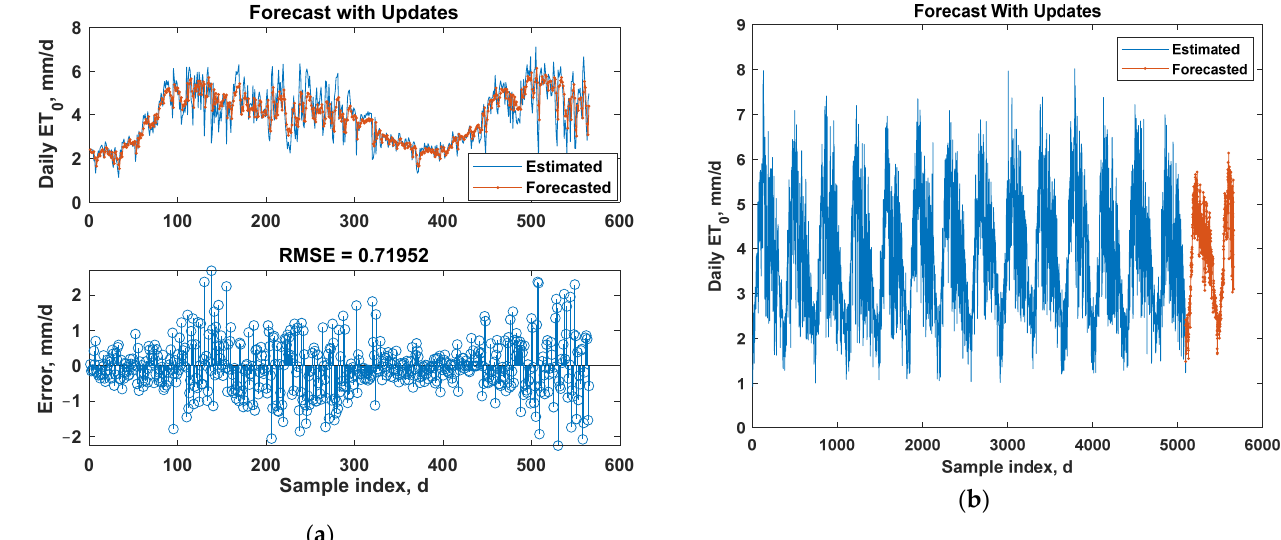
Figure 5. SSR-LSTM performance after network updating: ( a ) estimated (FAO-56 PM-computed) and SSR-LSTM-forecasted ET 0 values for the test dataset; ( b ) future projections beyond the observed ET 0 values. ET 0